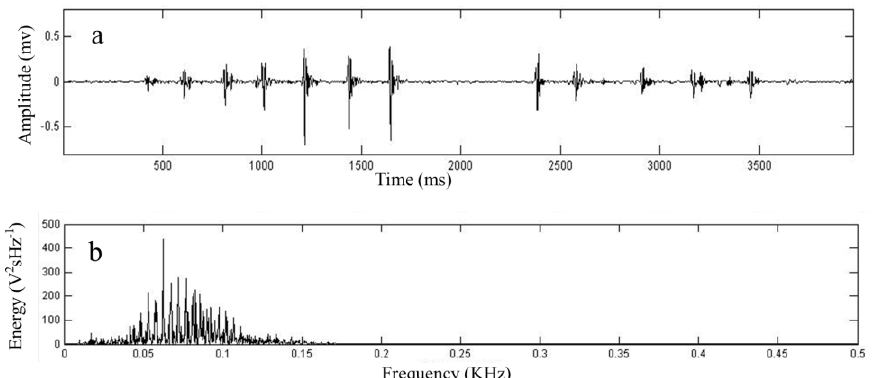
Figure 4. Seismic signal of plateau zokors in the control experiments without experimental burrows ( a ) and Seismic signal amplitude FFT-Spectrum plots ( b ).